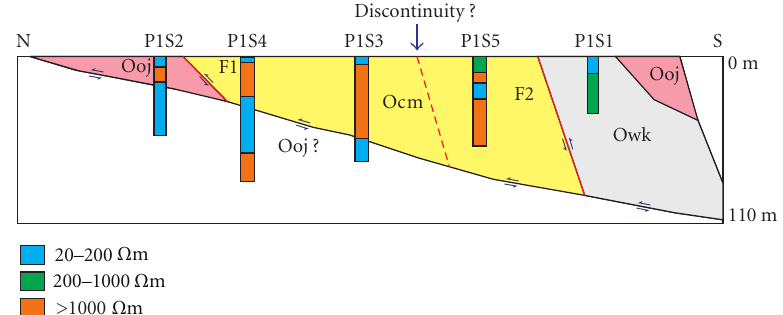
Figure 7: Interpreted fault geometry and subsurface geology along profile A-B relative to resistivity